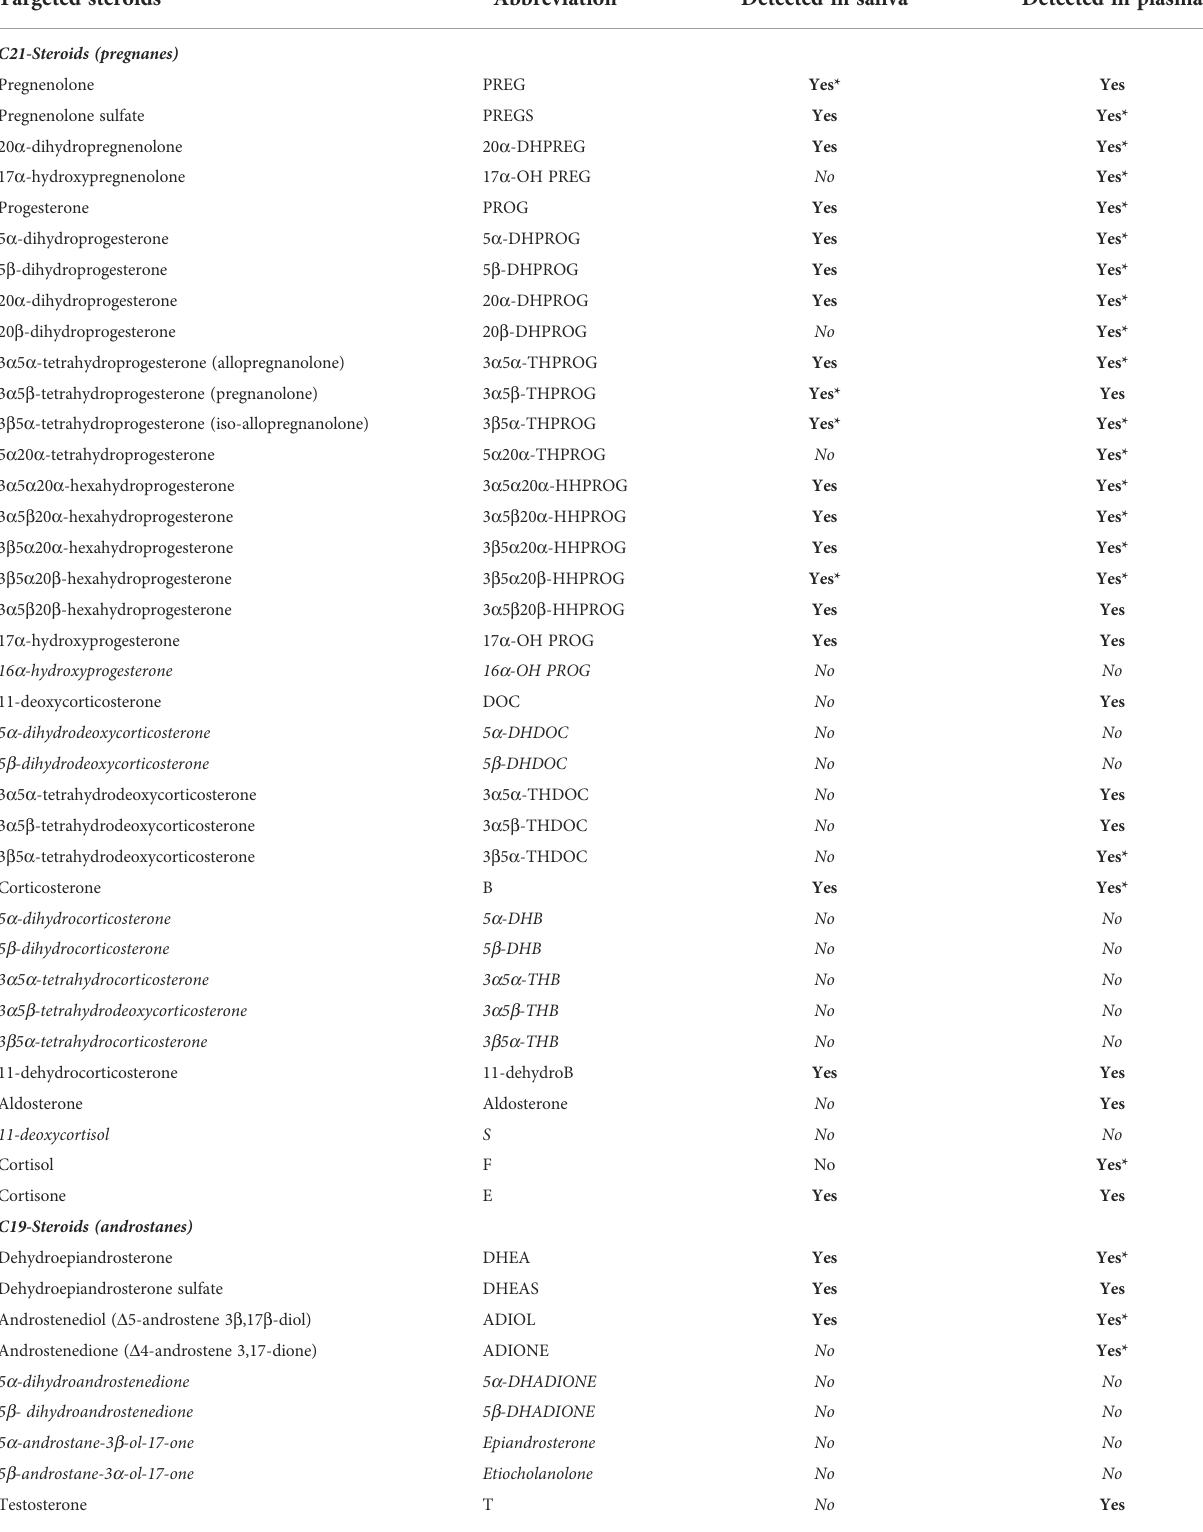
TABLE 1 Targeted steroids analyzed by GC-MS/MS in equine saliva and plasma and their